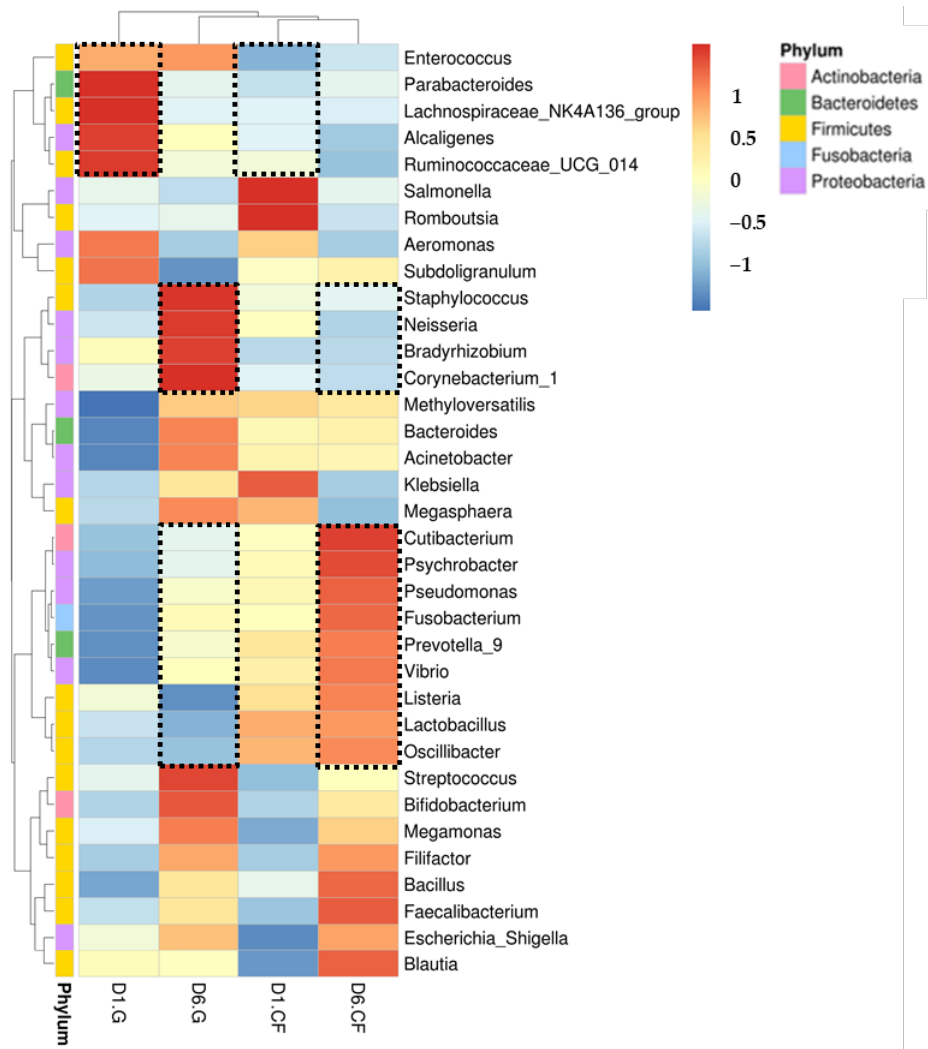
Figure 7. Heat-map and hierarchical clustering of genera of bacterial distribution in wound-contact chitosan and regular gauze dressings up to 6 d post-surgery. Black dash indicates significant difference between the groups (D1 = day 1, D6 = day 6, G = gauze, CF = chitosan).